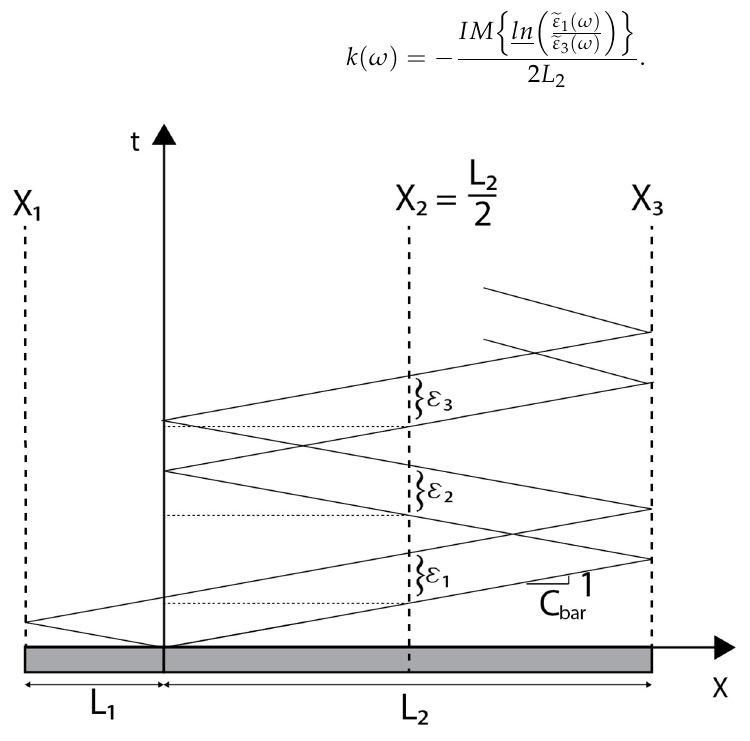
Figure 3. The T-X diagram of a striker bar of length L 1 impacting a single bar of length L 2 . This impact results in a traveling wave originating at X = 0 with the duration of 2 L 1 / C bar , and arrives at the measurement location, X 2 at times L 2 /2 C bar , 3 L 2 /2 C bar , 5 L 2 /2 C bar , and so on.